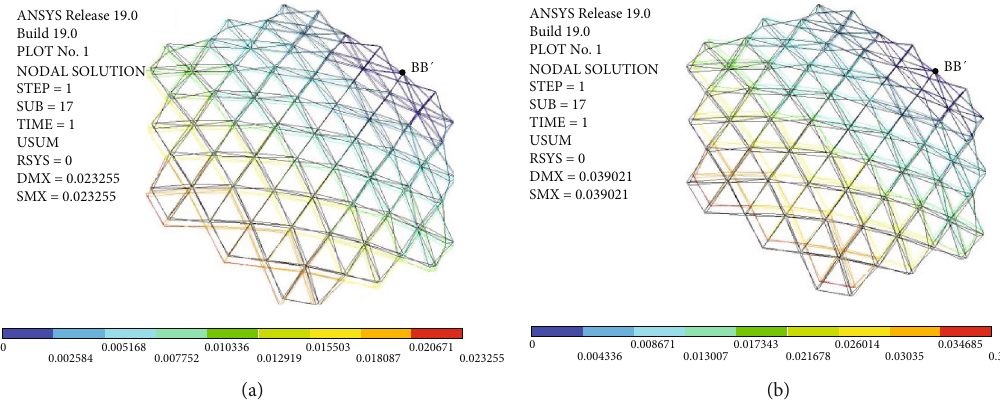
= 900s . (b) t = 1800s 1 2